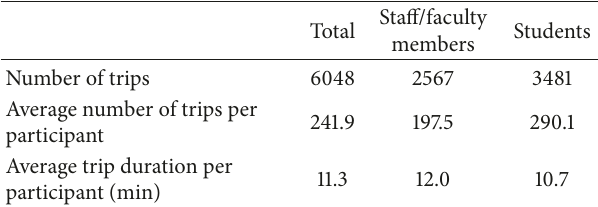
Table 2: WeBike trip